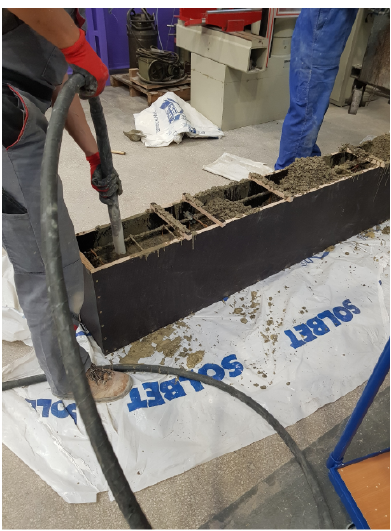
Figure 2. Vibration during pouring the concrete and collecting of specimens.